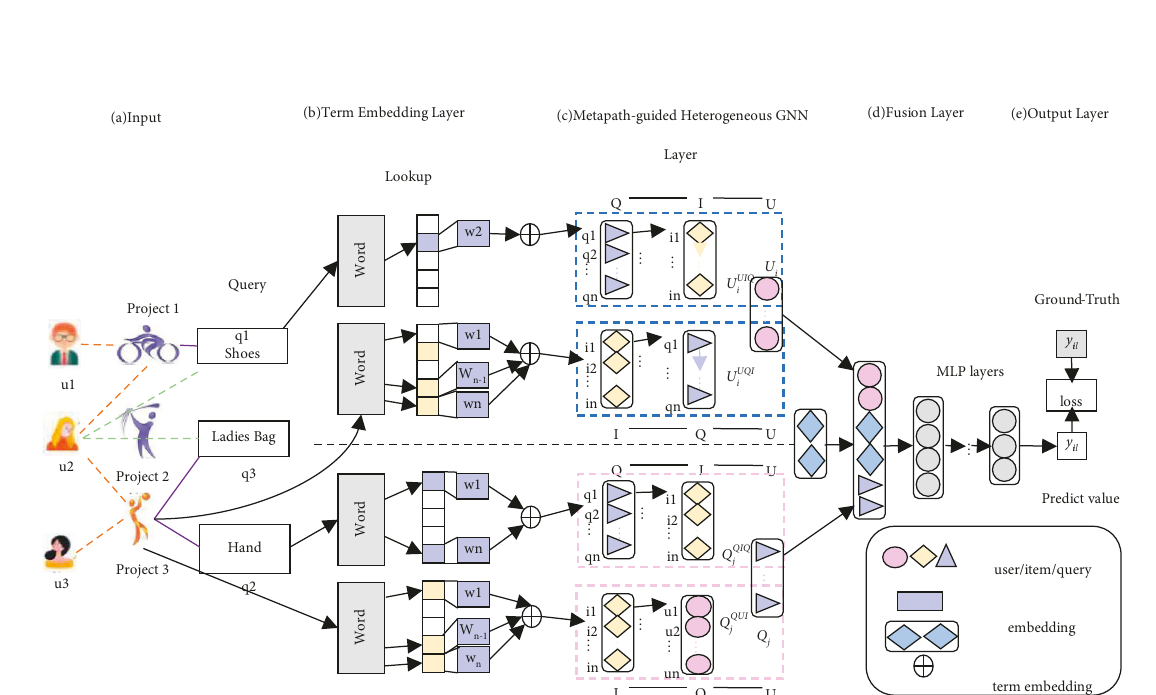
Figure 1: Research framework for physical fitness